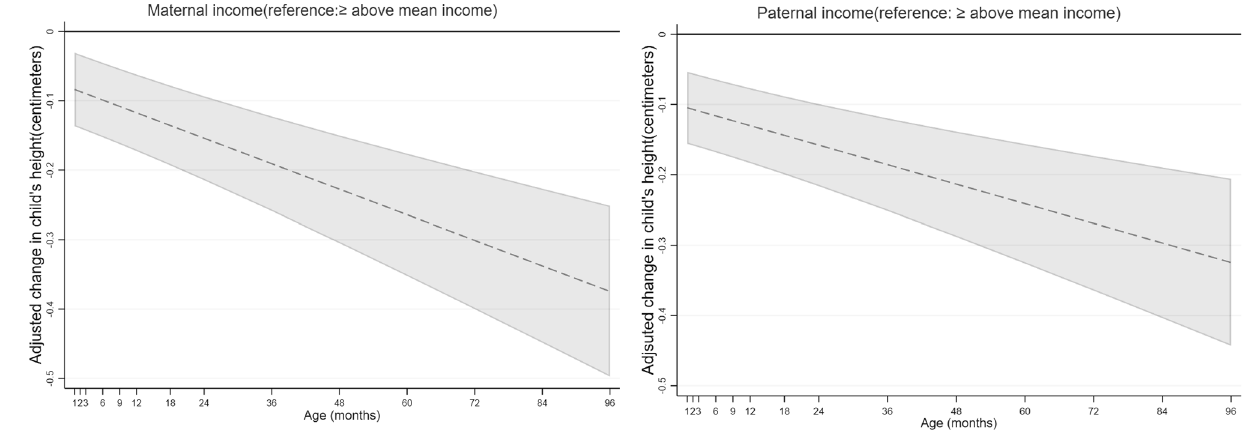
Figure 2. Associations between maternal and paternal income with children’s height in centimeters from 1 month to 8 year (β coefficients in dash lines and 95% CIs in solid lines).